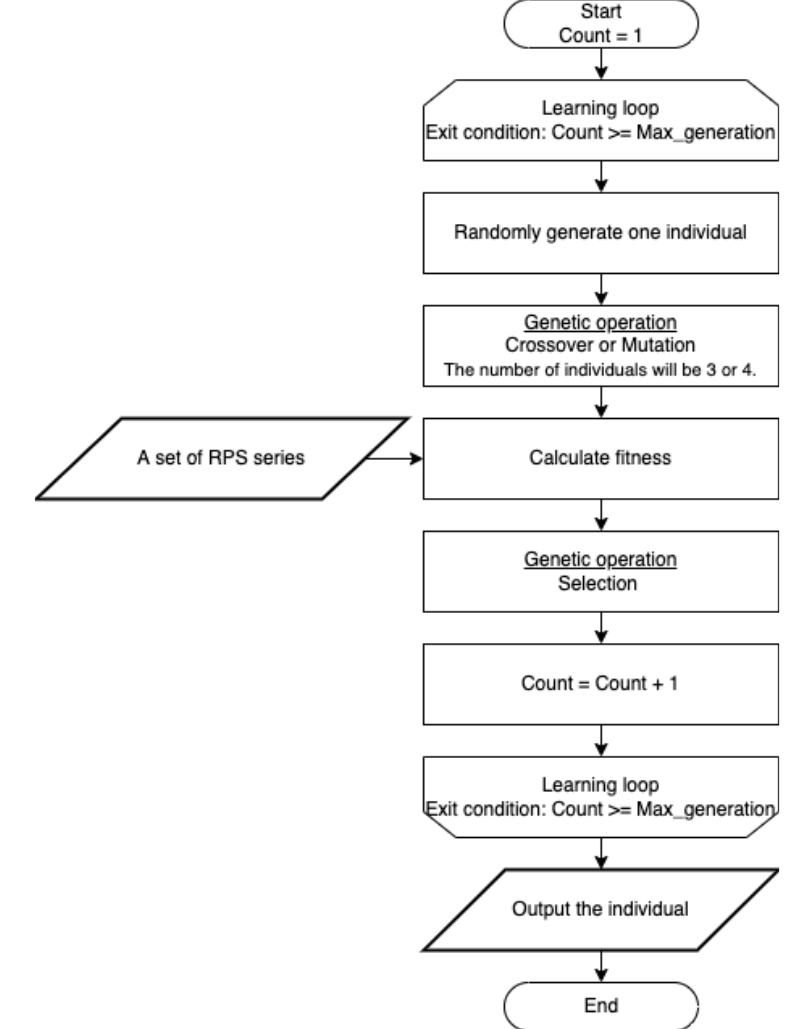
Figure 5. Flow of RPS strategy acquisition via